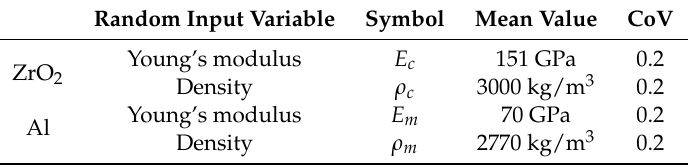
Table 2. The mean value and coefficient of variation (CoV) of random input parameters.